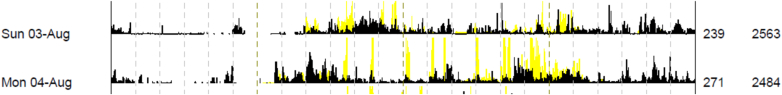
Snapshot of Betty.